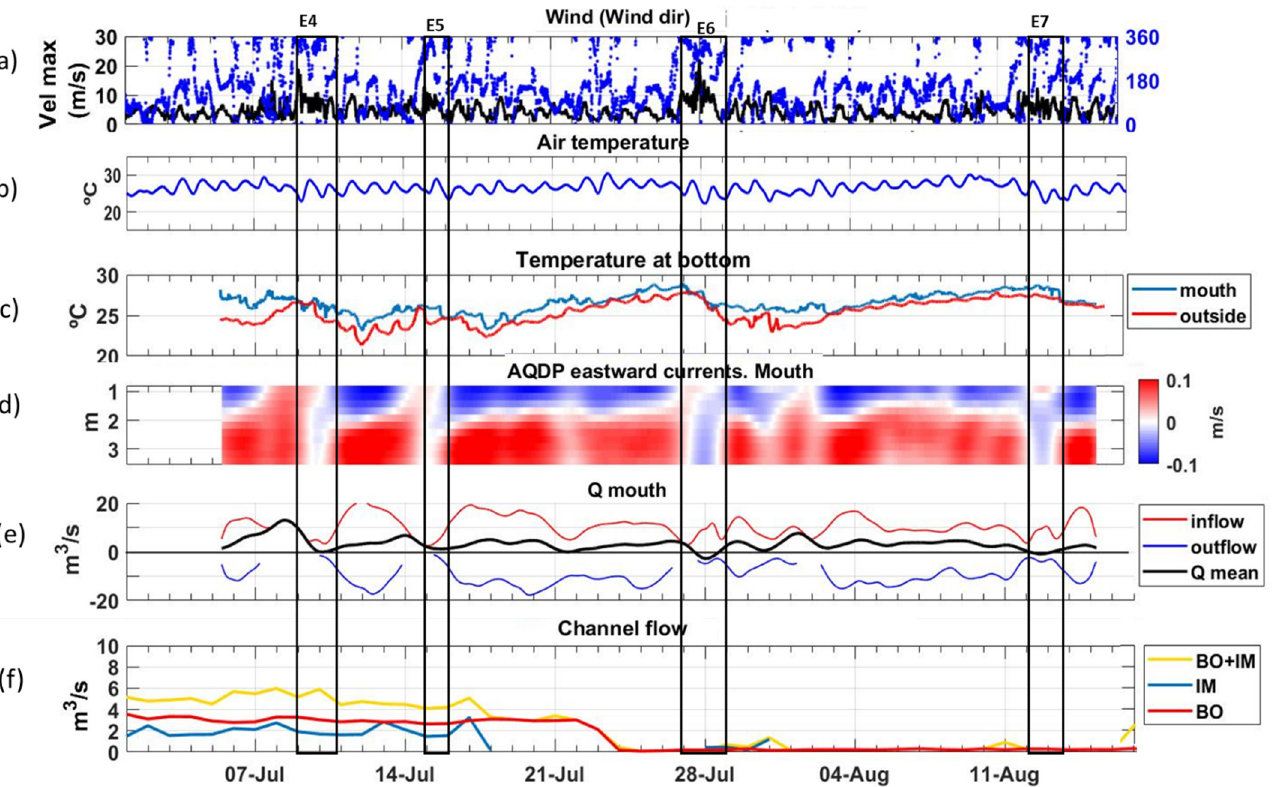
Figure 3. From top to bottom, wind speed ( a ), air temperature ( b ), bottom water temperature ( c ) alongshore currents in the mouth ( d ), inflow and outflow of the mouth ( e ), flow of the discharge channels ( f ). The black boxes show the events of the NW from 5 July to 6 September 2019 (FANGAR-IV). E4: 9–10 July; E5: 15–16 July; E6: 27–29 July; E7: 12–13 August.